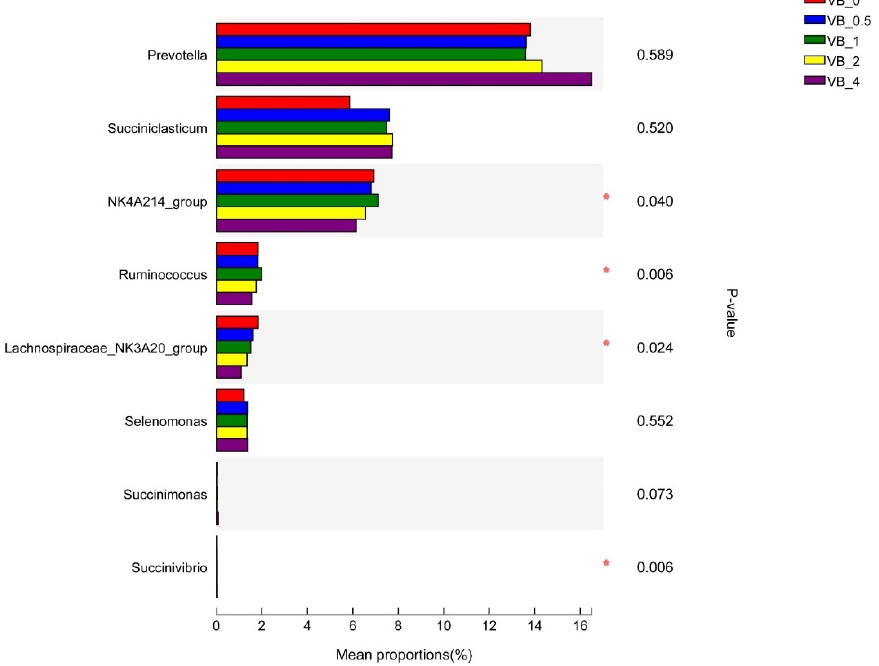
Figure 3. Changes in the bacterial genus level in the rumen fermentation system with increasing vitamin B 12 supplementation. (* p <